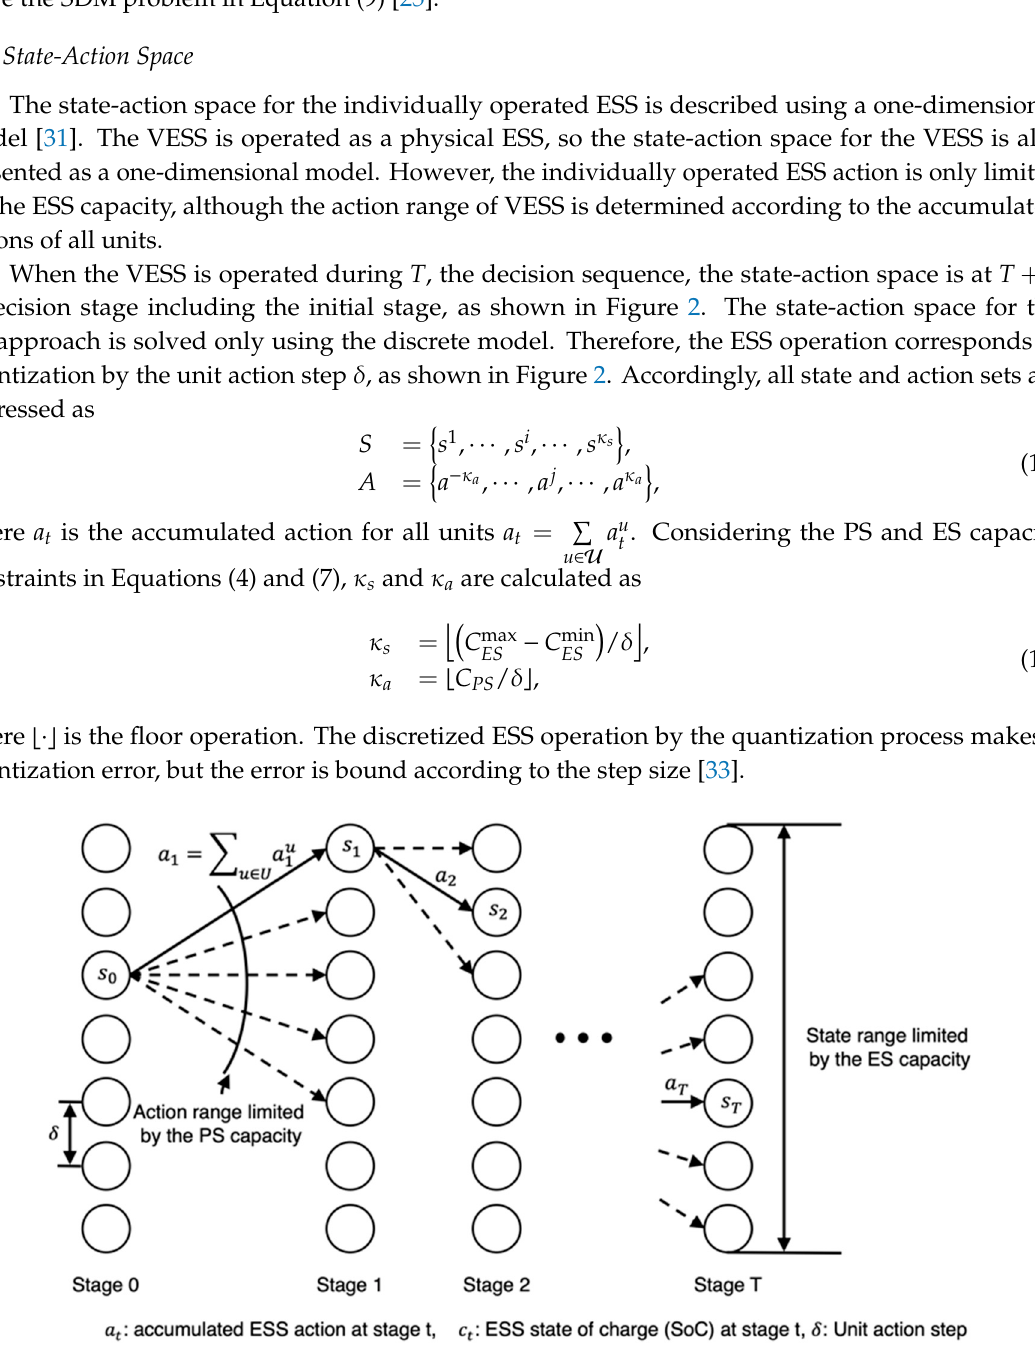
Figure 2. State-action space model for a virtual energy storage system; PS: power subsystem, ES: energy subsystem, and ESS: energy storage system.